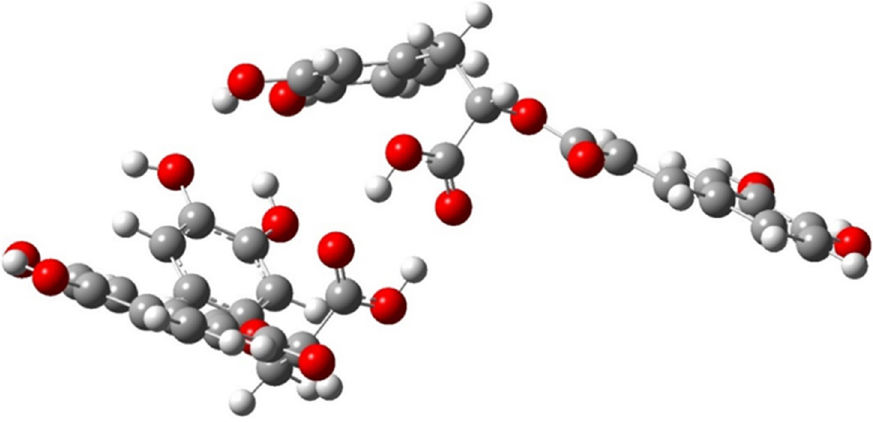
Figure 2. Interactions between RA molecules.